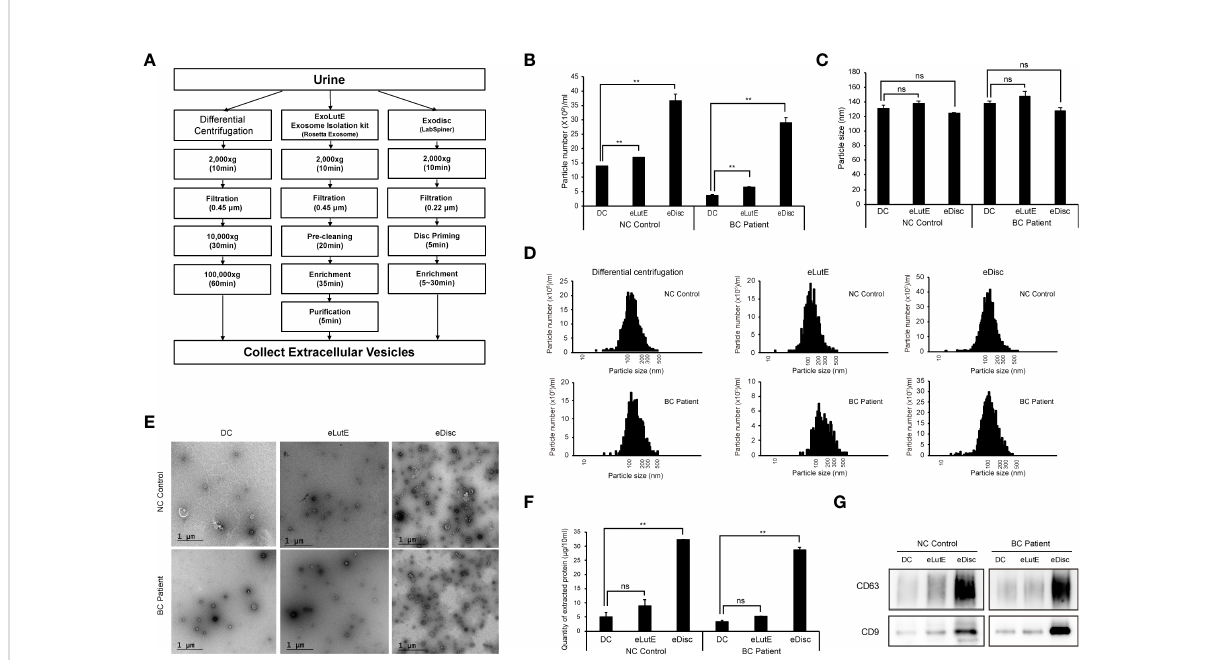
FIGURE 1 Comparison of the urinary EV separation ef fi ciency between three different methods. Extracellular vesicles (EVs) were separated via three different methods, namely differential centrifugation, the ExoLutE exosome isolation kit, and ExoDisc. Separation ef fi ciencies were then analyzed and compared. (A) Schematic summary of the EV separation methods. Human urine from one non-cancer control or bladder cancer patient was divided into three equal volumes (10 ml each), and each was subjected to a different isolation method. (B – D) Nanoparticle tracking analysis (NTA) of EVs separated through each method. The number (B) , size (C) , and size distribution (D) of EV particles separated via each method were determined through NTA. NC control: EVs isolated from non-cancer control, BC Patient: EVs isolated from bladder cancer patient. DC: EVs separated using differential centrifugation. eLutE: EVs separated using the ExoLutE exosome isolation kit. eDisc: EVs separated using ExoDisc from LabSpinner. Data are presented as the mean ± SD, n = 3, * p <0.05, ** p <0.01, ns: not signi fi cant. (E) Transmission electron microscopy (TEM) images of separated EVs. (F) Quanti fi cation of protein in EV particles separated via each method. EV protein was quanti fi ed using the micro bicinchoninic acid (BCA) protein assay. Data are presented as the mean ± SD of three independent experiments, ** p <0.01, ns, not signi fi cant. (G) Western blot analysis of CD63 and CD9 expression in EV particles separated via each